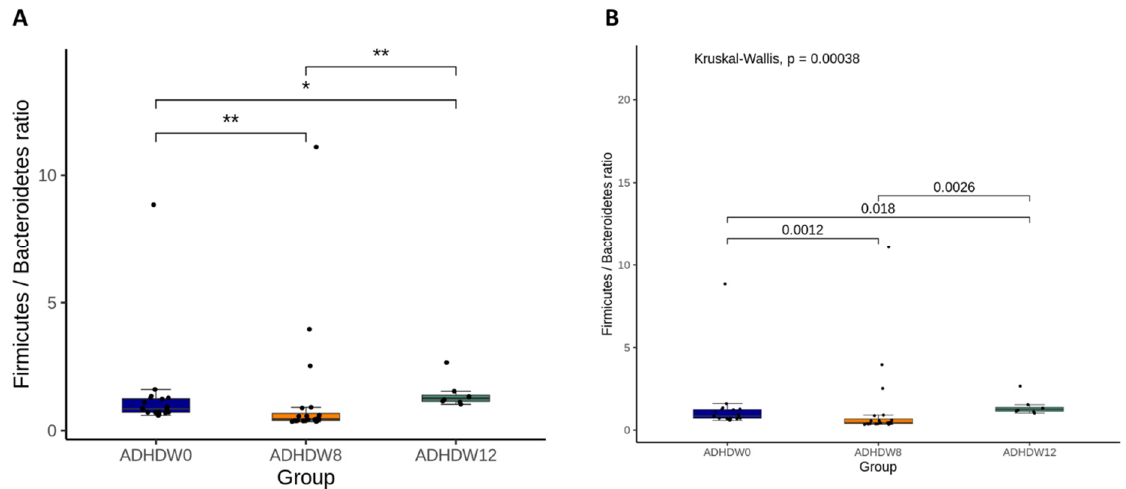
Figure 3. The Firmicutes to Bacteroidetes ratio (F/B ratio) at baseline, week 8, and week 12. Statistical analyses used analysis of variance (ANOVA) ( A ) and the Kruskal–Wallis test ( B ). * p < 0.05, ** p < 0.01.